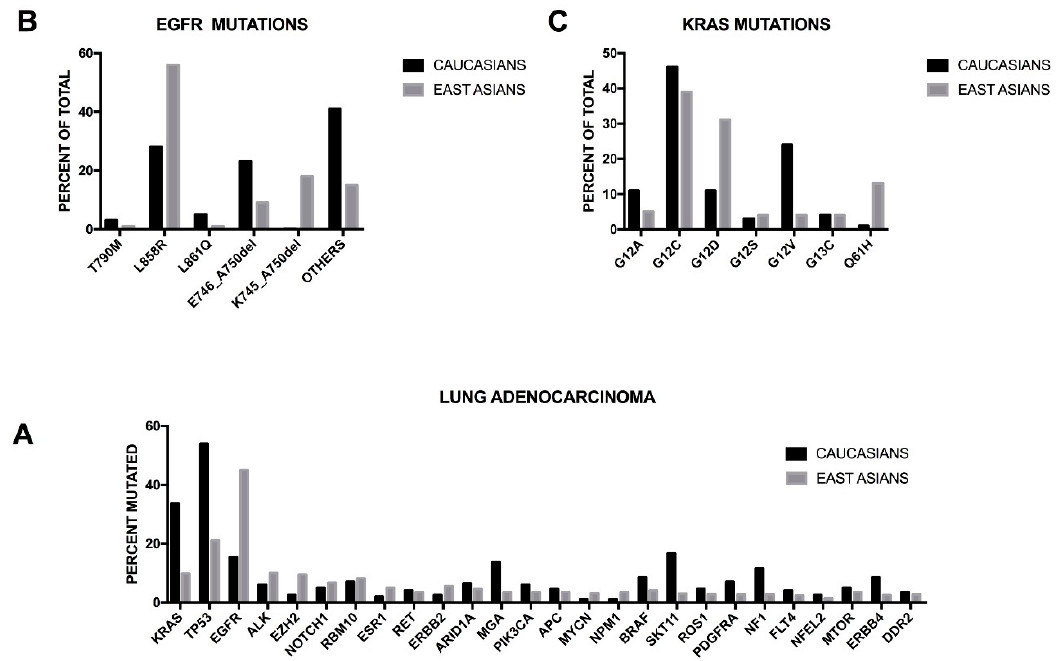
Figure 1. ( A ) Comparison of the most recurrent gene mutations in lung adenocarcinoma between Caucasians and EAST Asians; ( B ) Various gene mutations at the level of the EGFR gene in Caucasians and East Asians; ( C ) Various gene mutations at the level of the KRAS gene in Caucasians and East Asians. Data are reported in [13,17].